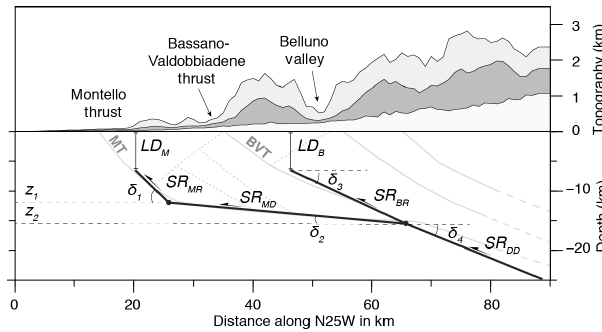
Figure 6. Sketch of the geometries for two-dimensional fault model as described in Sect. 4. LDM (locking depth of Montello fault), LDB (locking depth of Bassano fault), SRMR (slip rate of Mon- tello ramp), SRMD (slip rate of Montello décollement), SRBR (slip rate of Bassano ramp) and SRDD (slip rate of the Deep ramp) are the fault parameters estimated from the data inversion (see Ta- ble 2). The dip angles of each fault segment ( δ 1 = 45 ◦ , δ 2 = 5 ◦ , δ 3 = 25 ◦ , δ 4 = 22 ◦ ) and the depth of fault junctions ( z 1 = 12km, z 2 = 15 . 5km) have been kept